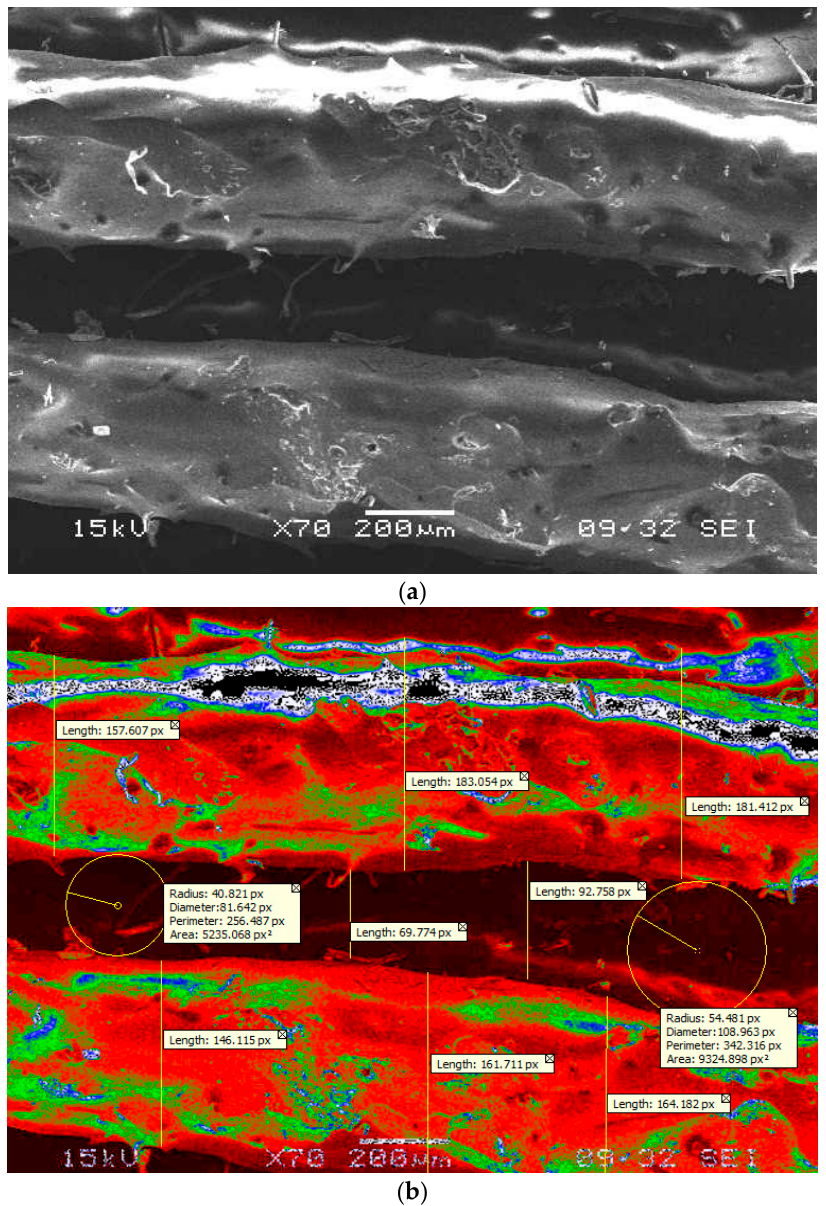
Figure 15. ( a ) SEM micrograph at 200 µ m, ( b ) assessment of fibers at 0 ◦ by image segments